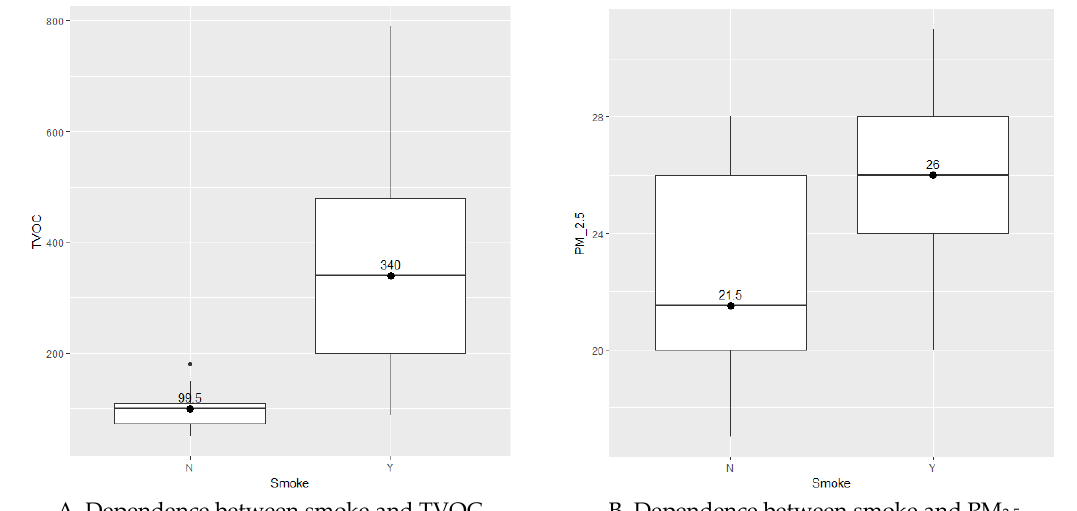
Figure 4. Box plots of significant factor smoke with medians. N, no; Y, yes.